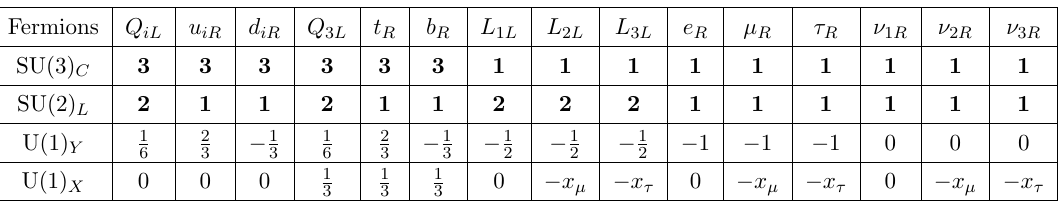
Table 1 . Charge assignment for the SM fermions and right-handed neutrinos where the indices i = 1 ; 2 indicate the (cid:12)rst and second